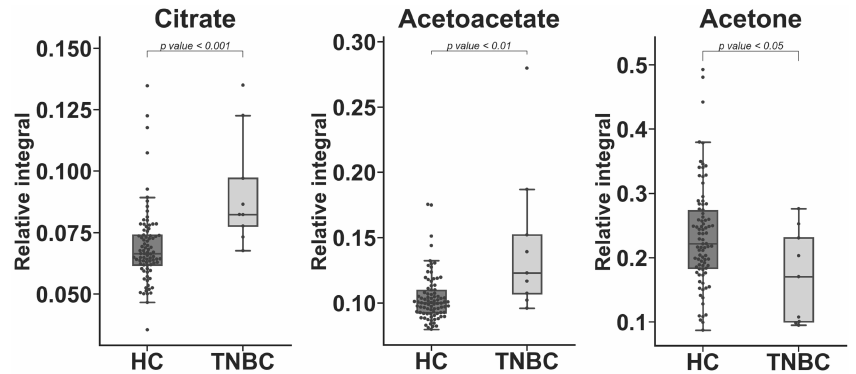
Figure 3. Statistically important metabolites identified in the HC vs. TNBC comparison but not identified in the cell line medium experiment. Whiskers = 1.5 × IQR; lines = average; boxes = interquartile range Q1–Q3.